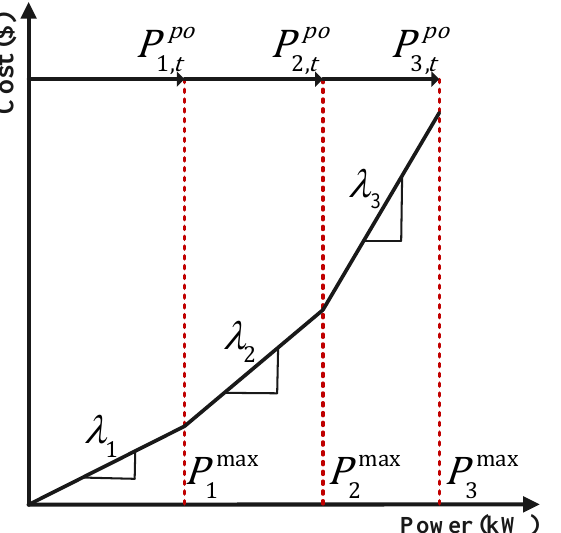
Figure 3. Piecewise linear approximation for the cost function of the power-only units